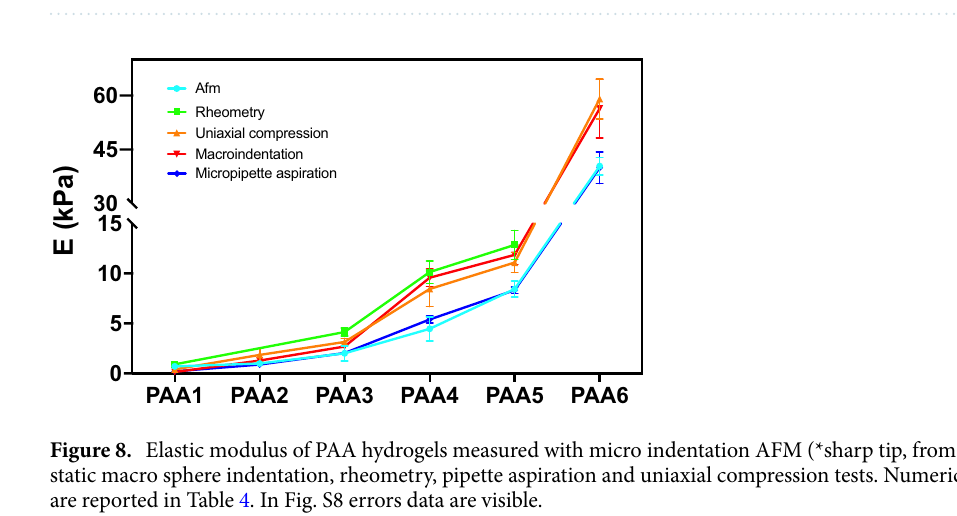
Figure 7. Schemes of the stresses applied to the hydrogels in the different techniques (column 2), experimental output achieved from the measurements (force/strain relationship or deformation state image, column 3), their relationship with the final result (column 4), the Young elastic modulus E.